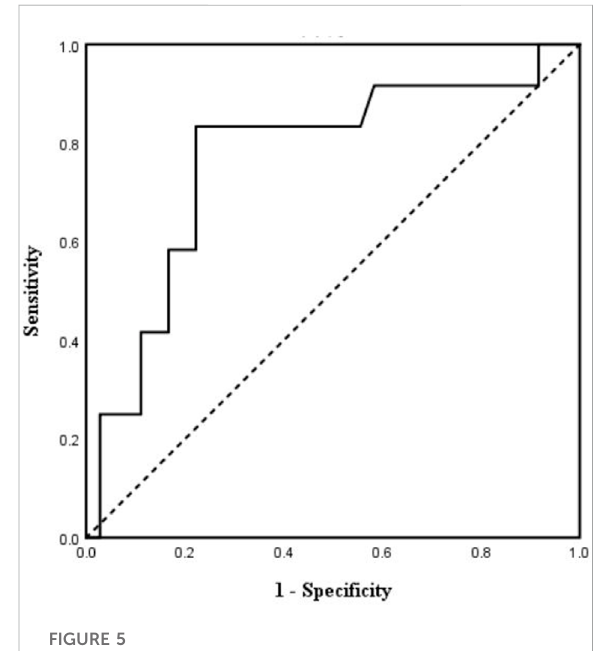
FIGURE 5 Receiver operating characteristic curve analysis of post- implant TpTe according to echocardiographic response ( n = 48). TpTe: Tpeak-Tend